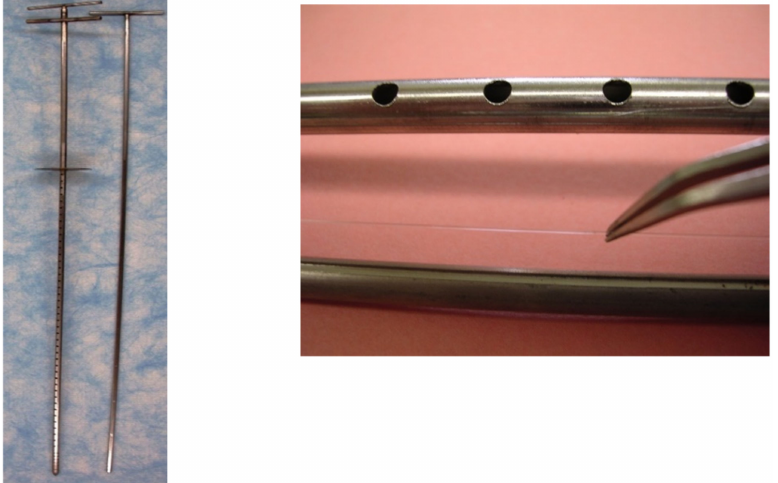
Figure 3. SPME sampler with a 90 cm working section showing perforated outer shield tube and inner rod ( left ). Close-up of the perforated shield tube; the inner rod with slit and the PDMS are also shown ( right ). The fiber has 0.59 µ L/cm of PDMS around a 497 µ m-diameter glass